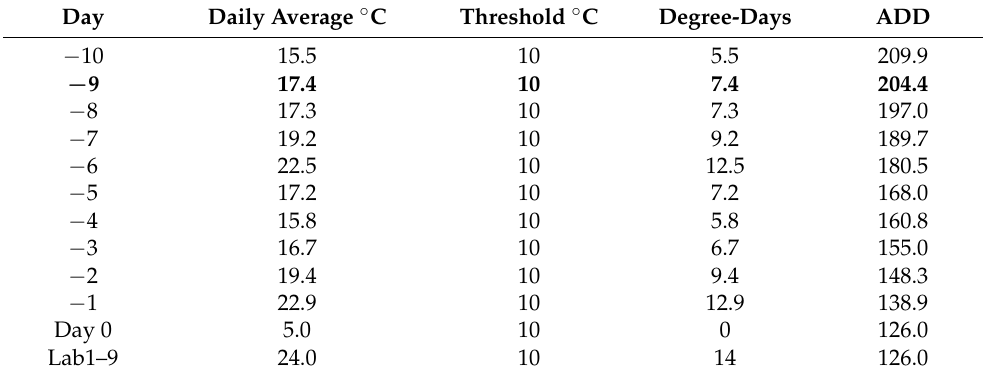
Table 1. Calculation of accumulated degree-days (ADD) for Phormia regina , based on temperature information from the nearest weather station. bold: estimated day of body deposition Day Daily Average ◦ C Threshold ◦ C Degree-Days ADD −